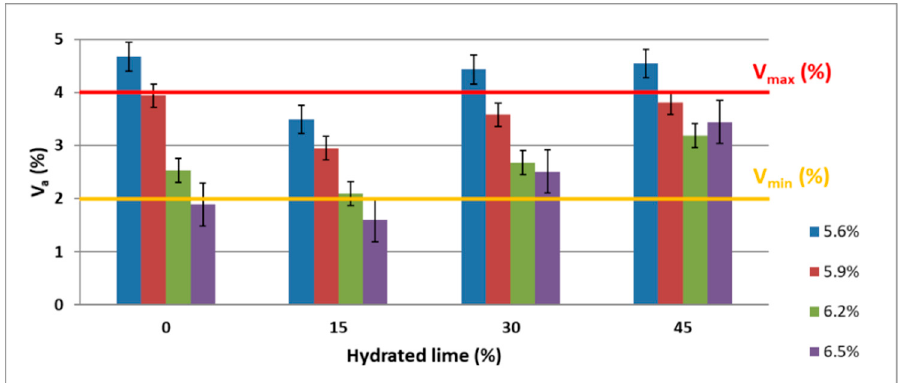
Figure 5. Air void content in AC 8 S as a function of the content of hydrated lime (0%, 15%, 30%, 45%) and foamed bitumen modified with 0.6% SAA (5.6%, 5.9%, 6.2%, 6.5%).